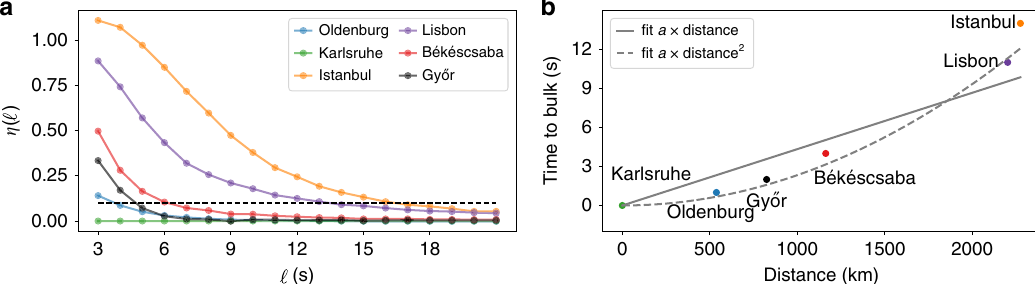
Fig. 8 The time-to-bulk increases with distance. a The relative DFA function η ( ℓ ) with Karlsruhe as reference; we determine the time-to-bulk as the time when this value reaches 0.1 (dashed line) (see also Eq. (5)). b We plot the so-extracted time-to-bulk vs. the distance from Karlsruhe and provide a simple fi t for the fi rst fi ve points (i.e., excluding Istanbul, as it clearly behaves differently). We obtain a value for the linear fi t a = 5.2 × 10 − 1 s km − 1 , see Methods for details on the distance.